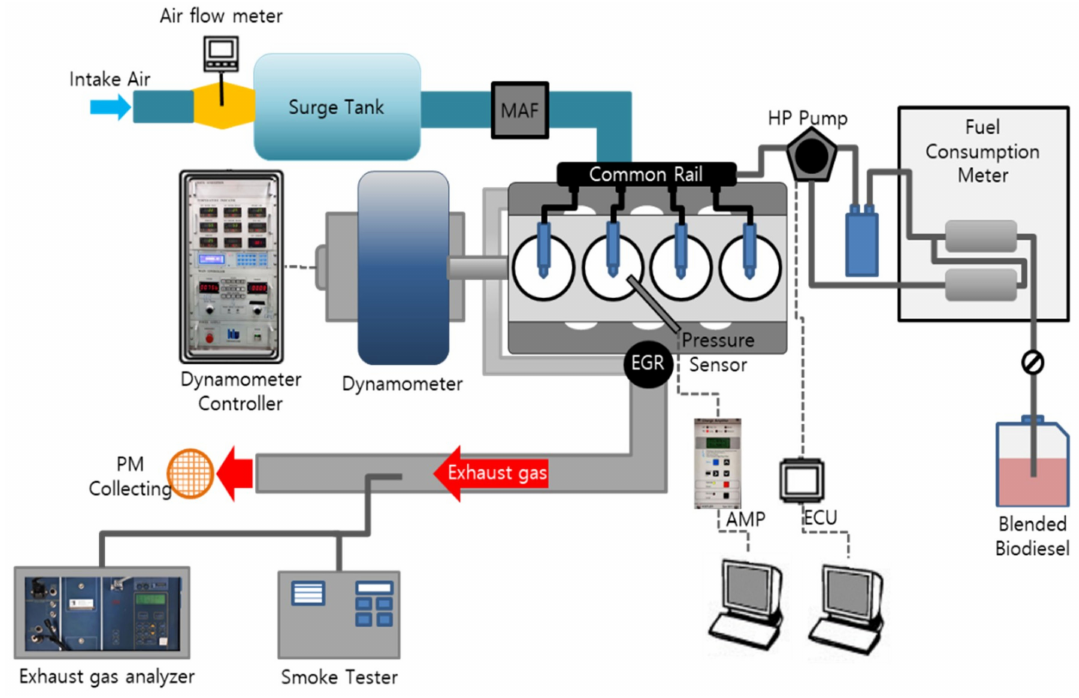
Figure 1. Schematic diagram of the experimental